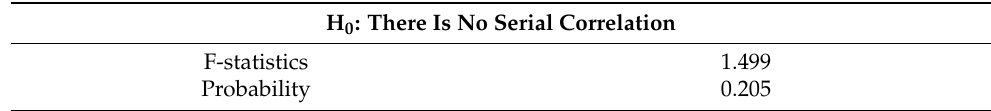
Table 8. Serial correlation test: INP, INF, EDU, PRO, DEP, INC. H 0 : There Is No Serial Correlation